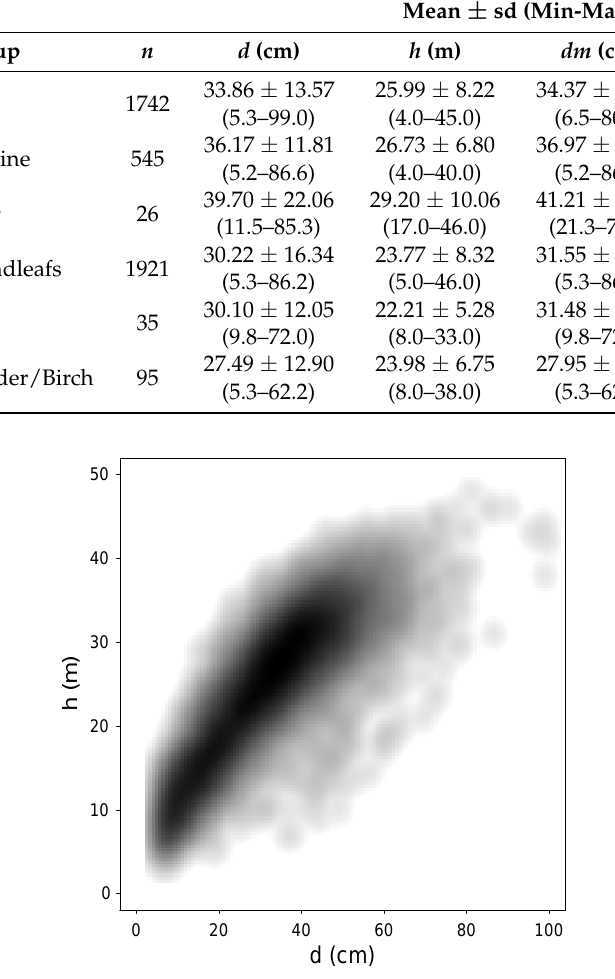
Table 5. Summary statistics of the evaluation data with respect to species groups. d = diameter at breast height; h = height; dm = diameter of the median basal area tree; hm = height of the median basal area tree.